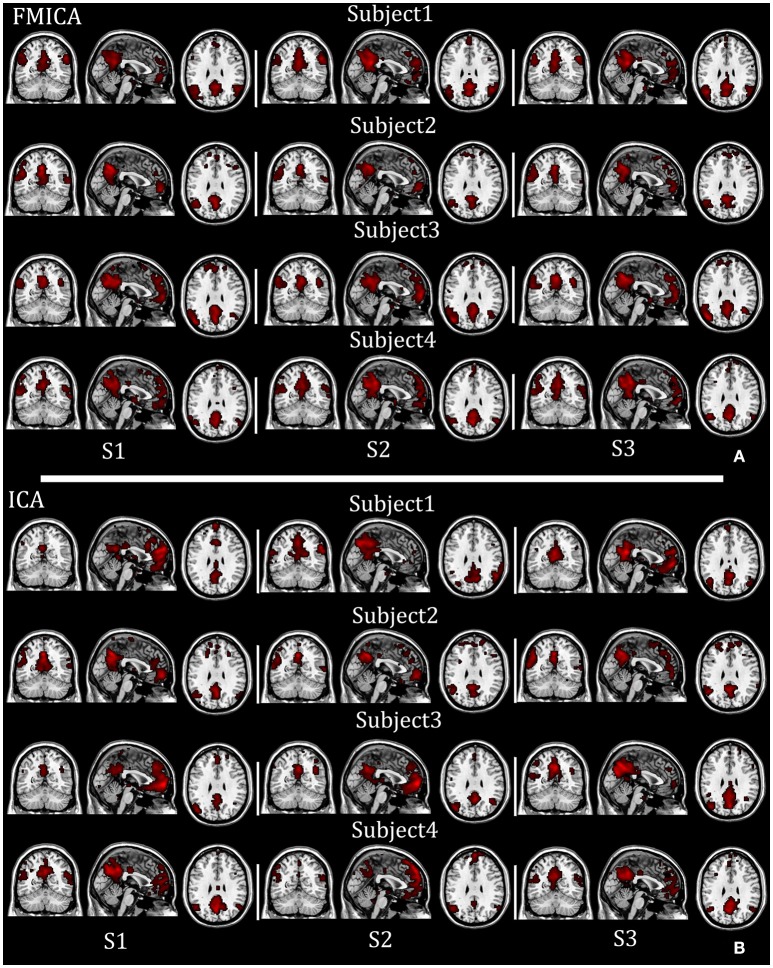
The individual DMNs identified by FMICA and FastICA on the test-retest resting-state fMRI datasets with respect to four examplars: (A) subject-specific DMNs identified by FMICA; (B) subject-specific DMNs identified by FastICA.